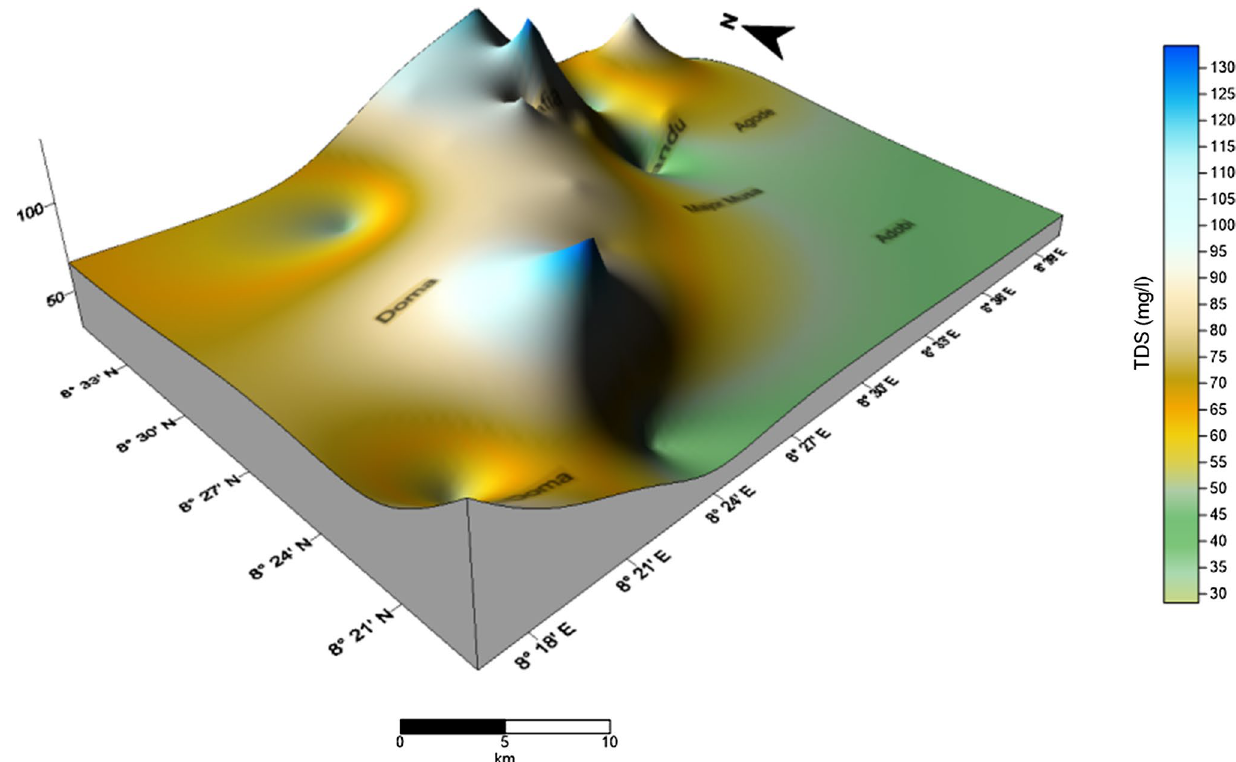
Fig. 7 3D TDS distribution map of the study